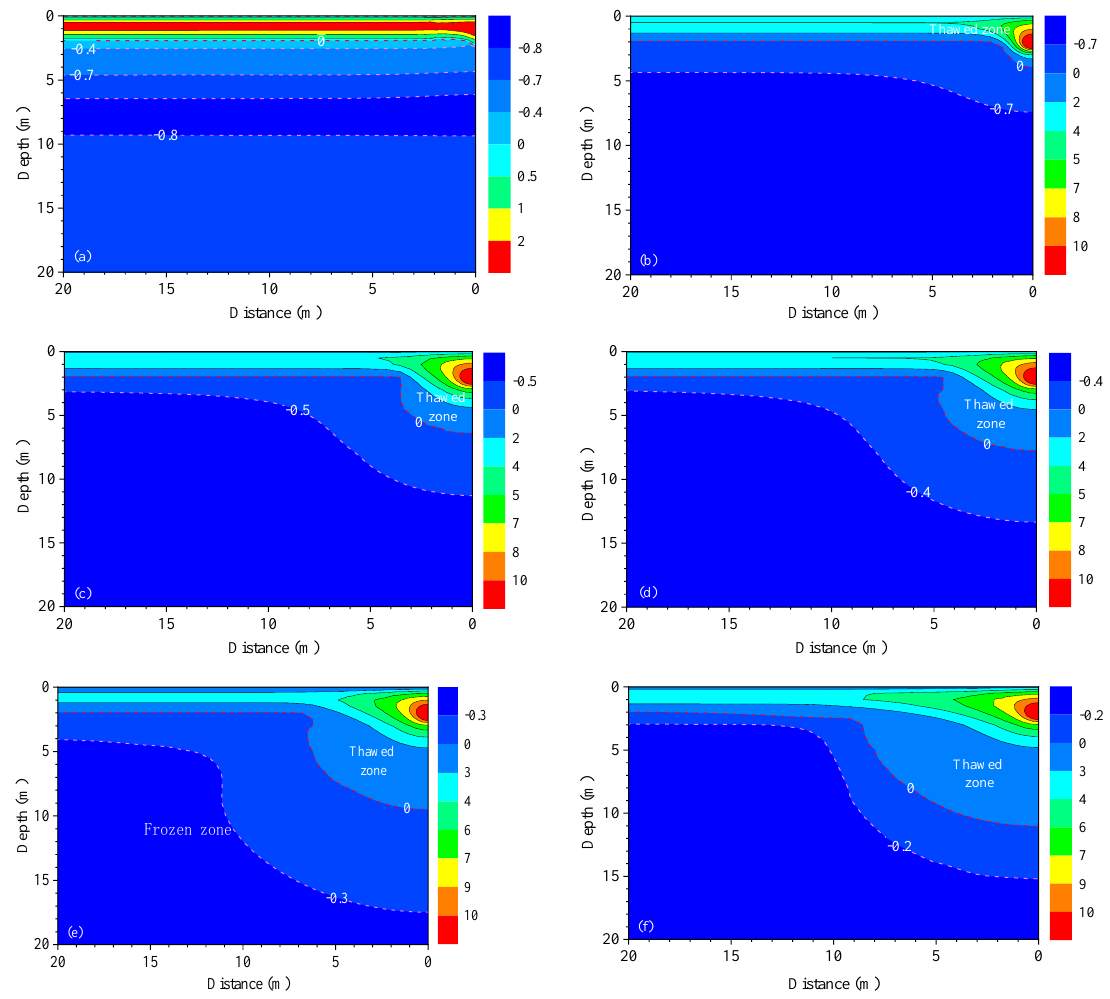
Figure 5. Geo-temperature distributions around the buried pipeline on October 15th at the 0 ( a ), 2nd ( b ), 5th ( c ), 10th ( d ), 20th ( e ) and 30th ( f ) year of operation. (Units: ◦